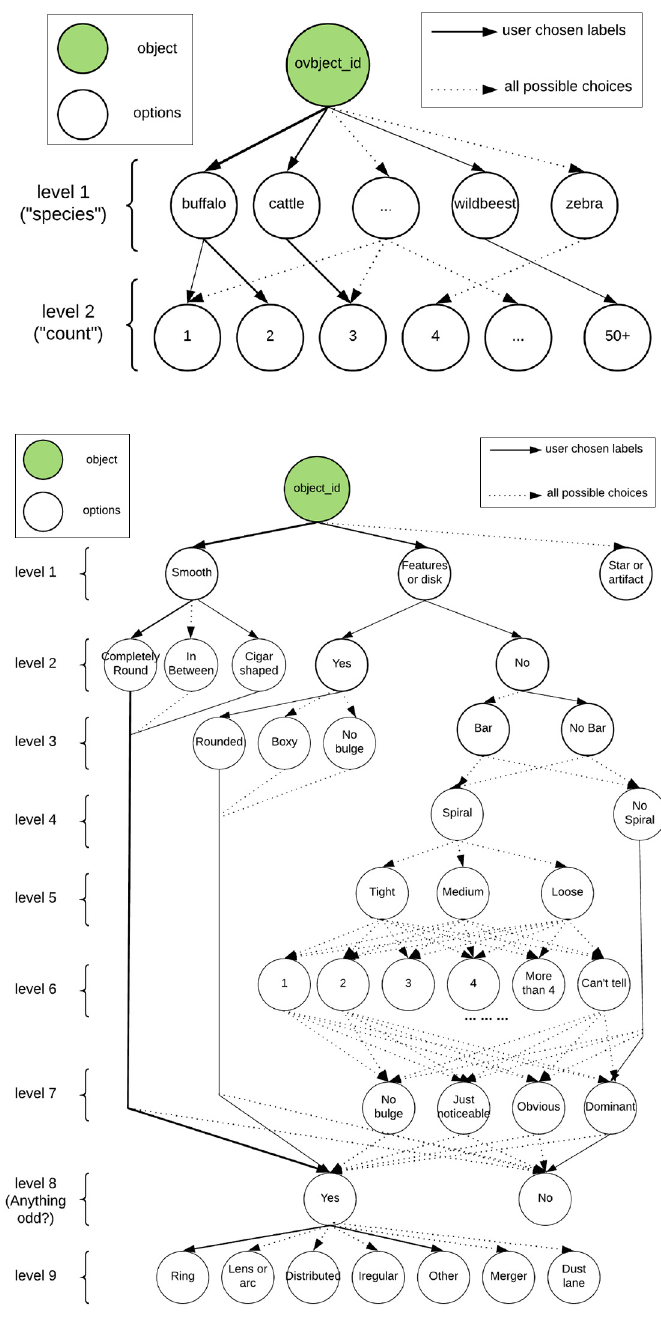
Figure 6. Representation of GalaxyZoo work fl ow from